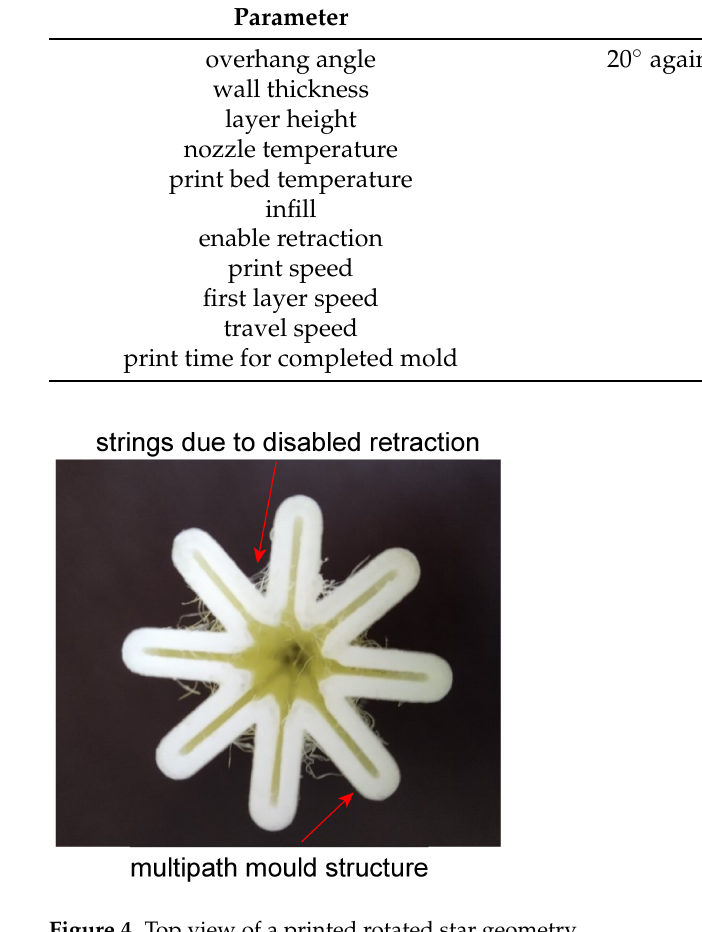
Figure 4. Top view of a printed rotated star